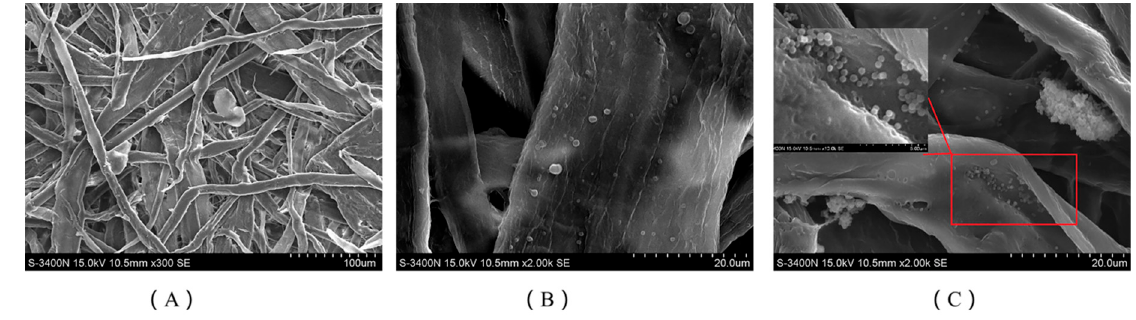
Figure 6. Scanning electron microscopy (SEM): ( A ) Untreated paper; ( B ) PLGA microparticles functional paper; ( C ) chitosan–PLGA microparticles functional paper.